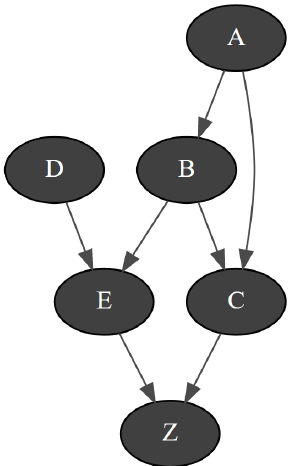
Figure 4. Representation of the network used to produce the